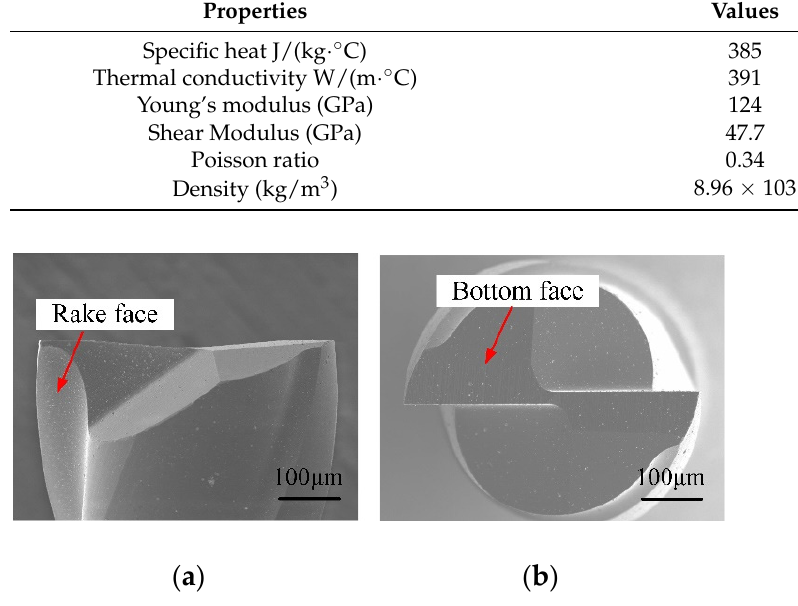
Figure 6. SEM images of carbide micromilling cutter. ( a ) Rake face; ( b ) Bottom face. Table 2. Physical properties of OFC-TU1 material.